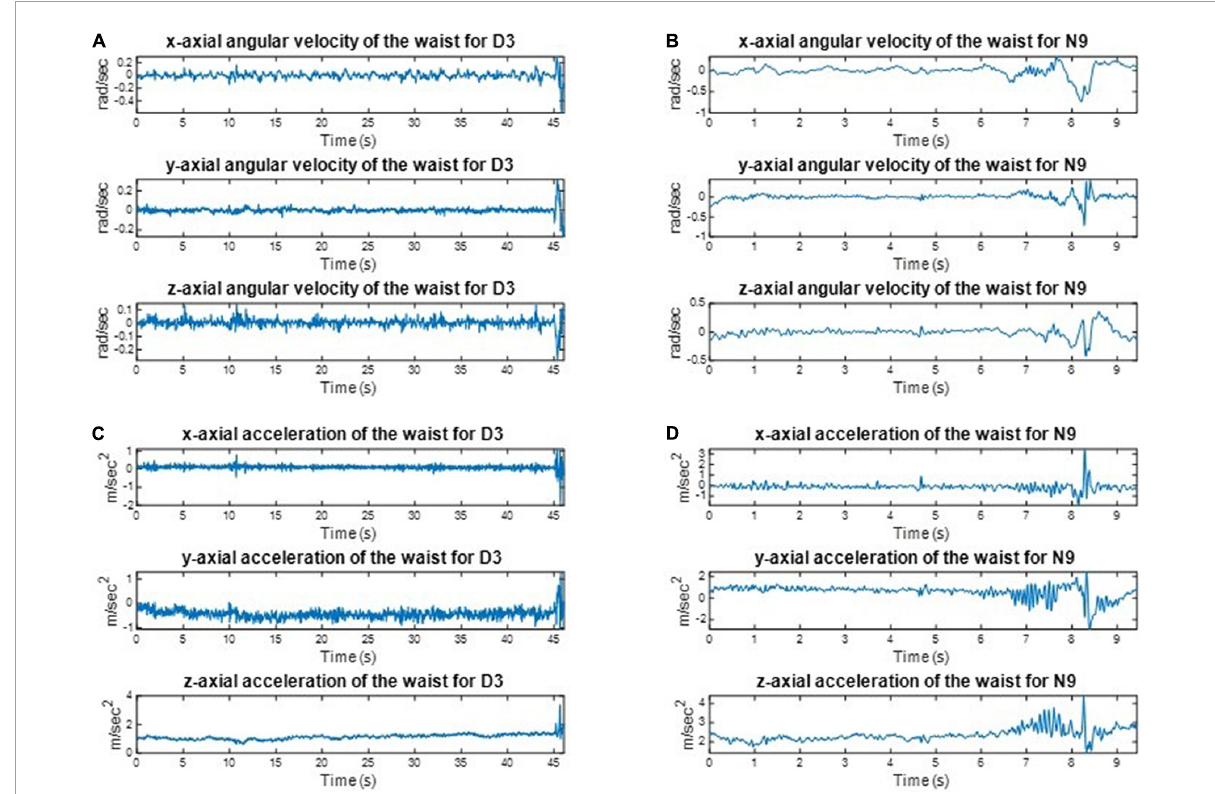
FIGURE8 The recorded kinematic data of D3 and N9 when standing on the dominant foot with eyes open. The dancers tended to make smaller movements than the control group to maintain body balance. (A) The angular velocities of D3. (B) The angular velocities of N9. (C) The linear accelerations of D3. (D) The linear accelerations of